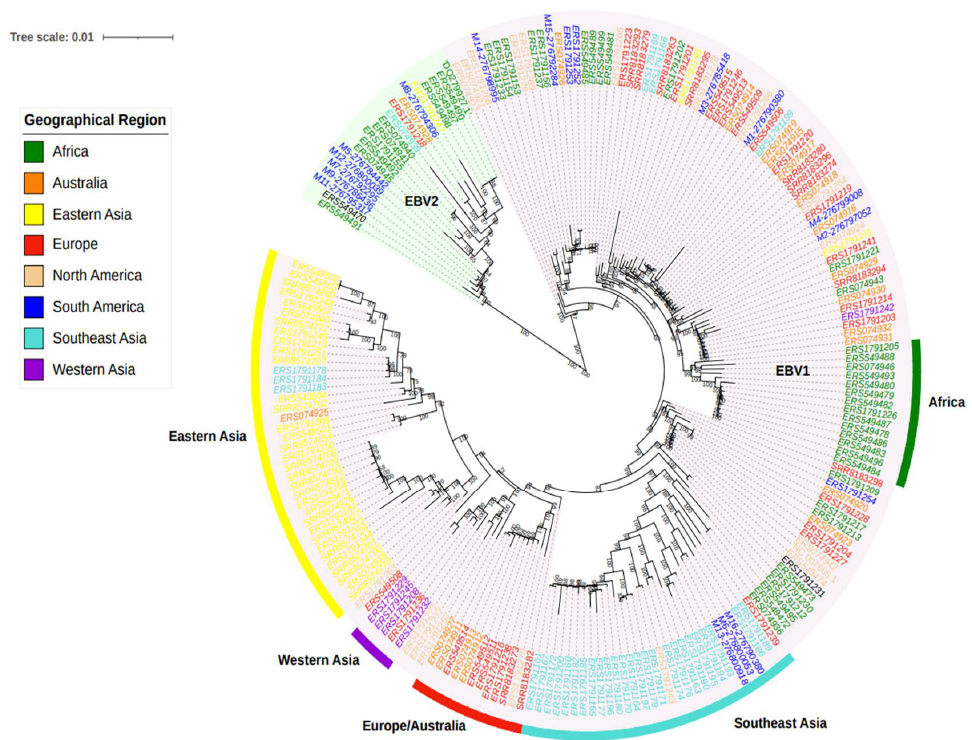
Figure 2. Phylogenetic reconstruction of 214 complete EBV genomes from different geographies. Phylogenetic tree constructed under the maximum likelihood method and 1000 ultrafast bootstrap resampling iterations. Only values over 70 are shown. The green shaded clade contains the EBV2 sequences and the pink shaded clade is EBV1. The color of each sequence represents the geographical region of the viral isolate. One sequence without a reliable origin of isolation is labeled in black (omitted in further analyses). The five subclades were highlighted using different externally colored bars. South American sequences correspond to isolates sequenced in the present study or were previously sequenced isolates from Argentina.